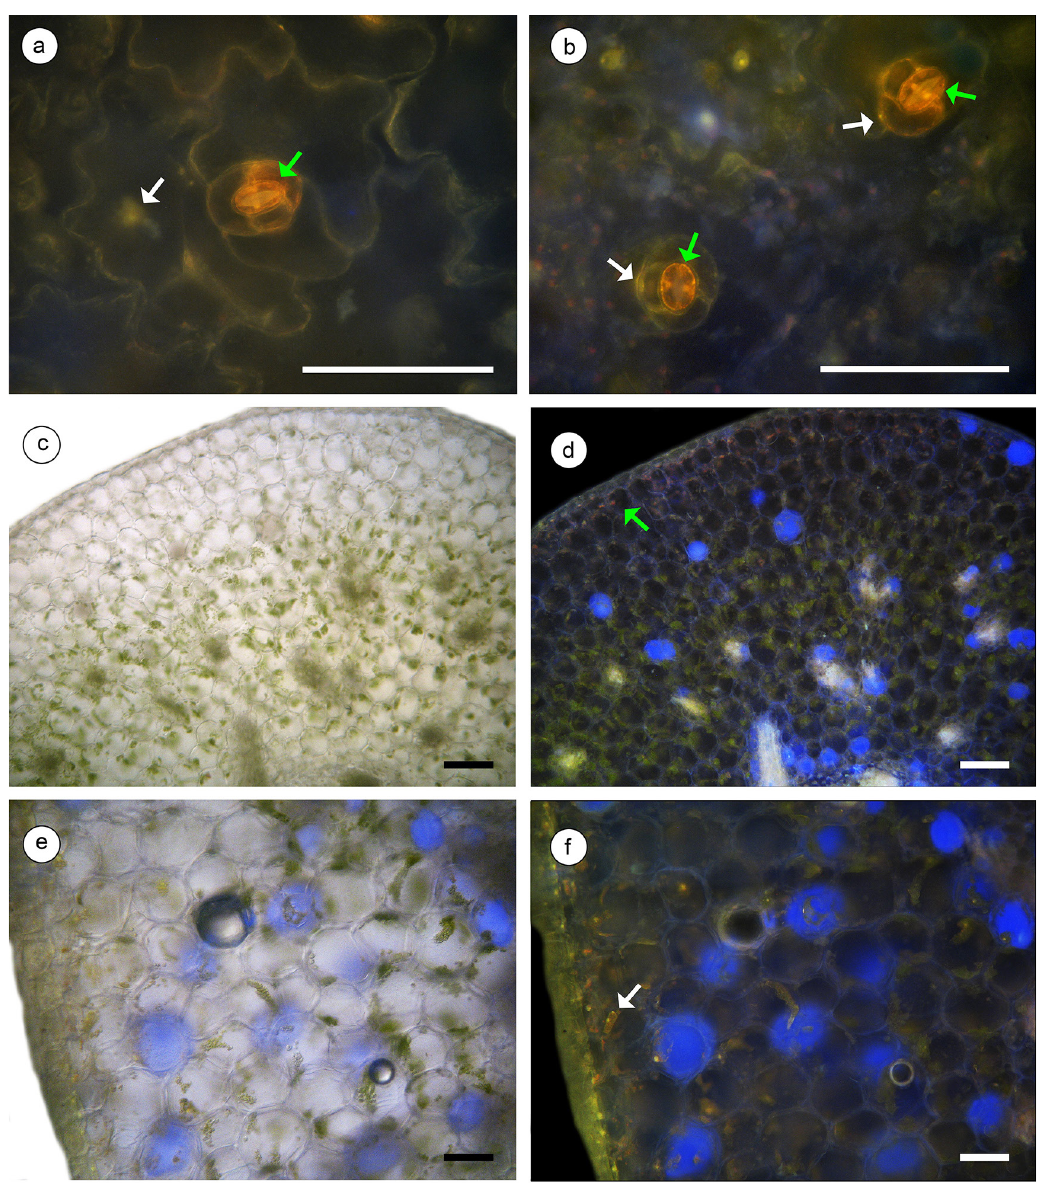
Fig. 7: Paradermal sections of Kalanchoe fedtschenkoi leaf blade at the middle third (NP treatment): adaxial surface (a, b). Cross sections of petiole at the median region (NP treatment): adaxial side (c, d); abaxial side (e, f); visible light (c); UV light (d, f); overlap of visible light and UV light (e); yellow flavonoids (white arrows); orange flavonoids (green arrows). Bars 100